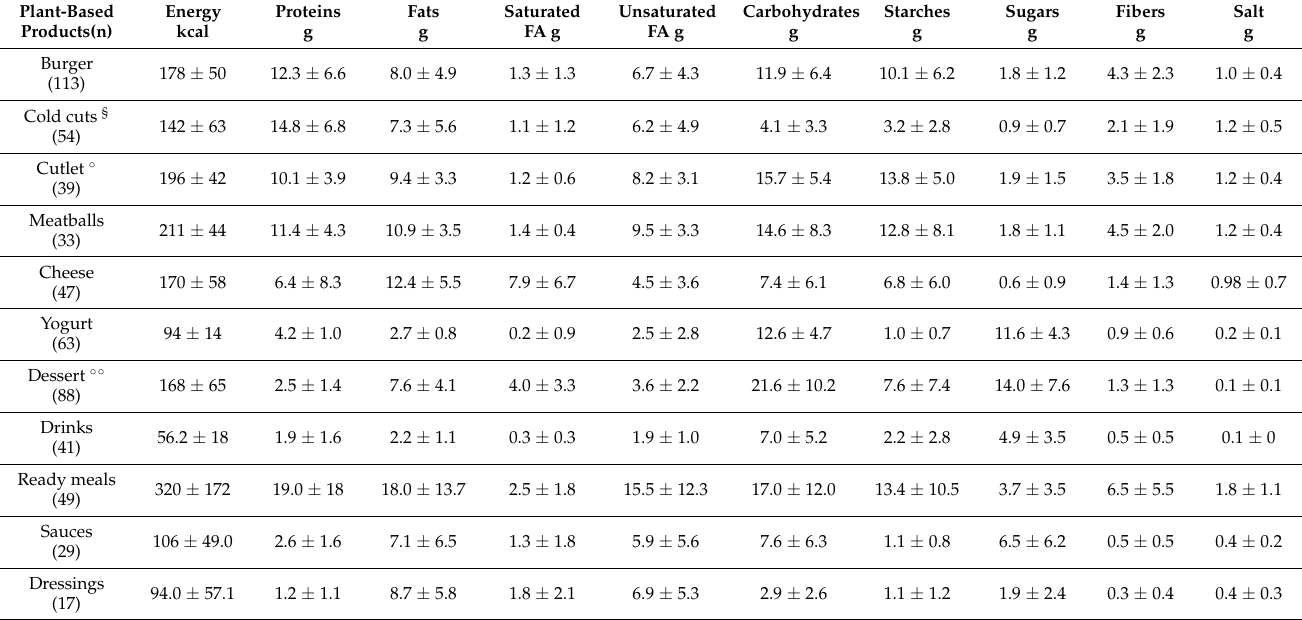
Table 1. Energy and nutrient content per 100 g of processed plant-based products analyzed in this study. All the data are presented as mean ± SD. The total number of analyzed products per category is reported in brackets. § Cold cuts include also sausages; ◦ Cutlet include also nuggets; ◦◦ Dessert include also ice creams; FA: fatty